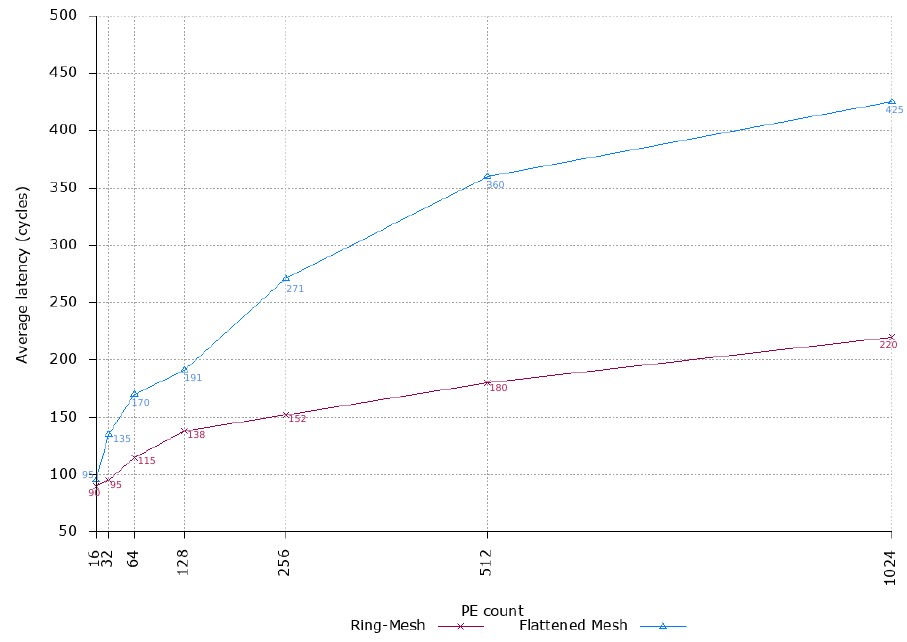
Figure 9. Average packet latency with increasing network